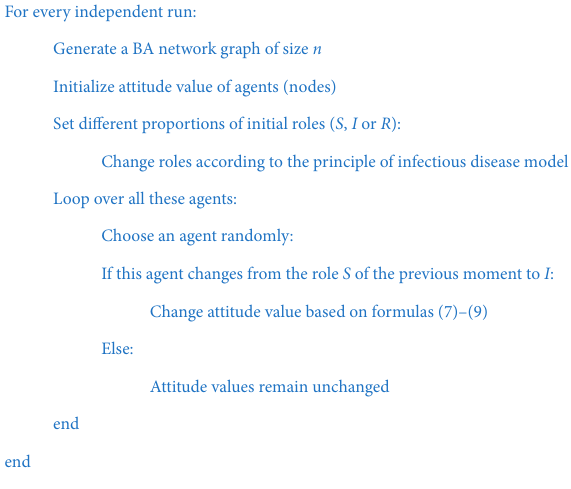
Figure 3: Pseudocode of the simulation